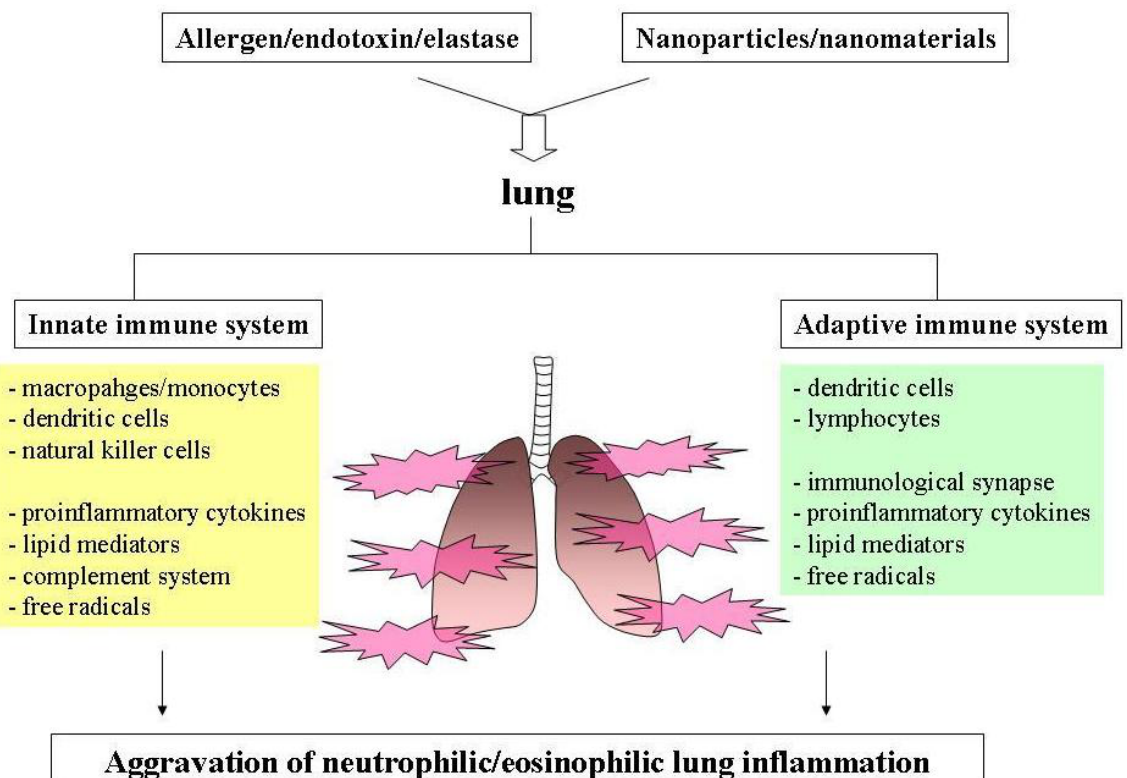
FIGURE 1. Proposal schema for aggravating effects of nanoparticles/nanomaterials on immune-mediated pulmonary inflammation. Regarding the impact on innate immunity, these particles may directly/indirectly influence on related cell populations, such as macrophages/monocytes, neutrophils, dendritic cells, natural killer cells, etc. As for adaptive immunity, in turn, nanoparticles/nanomaterials may potentially activate dendritic cells, lymphocytes, eosinophils, and mast cells/basophils. Furthermore, cell-cell interaction, intracellular signaling pathways, and/or chemical mediators, such as proinflammatory cytokines, complement system, and lipid mediators, may also be targets for these